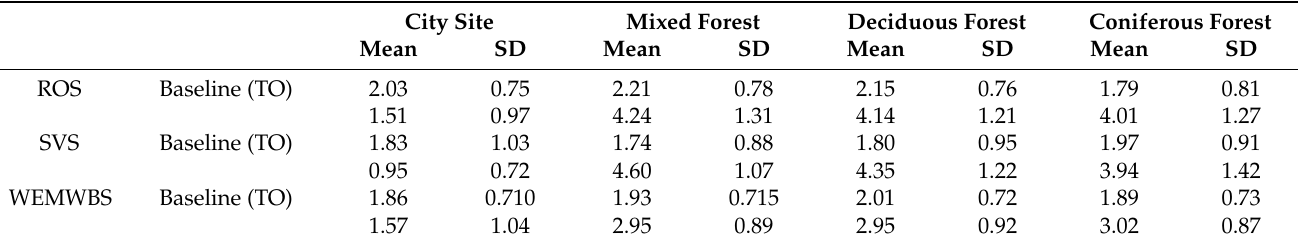
Table 4. Mean and standard deviation (SD) of psychological parameters (ROS, SVS, and WEMWBS) in the four experimental